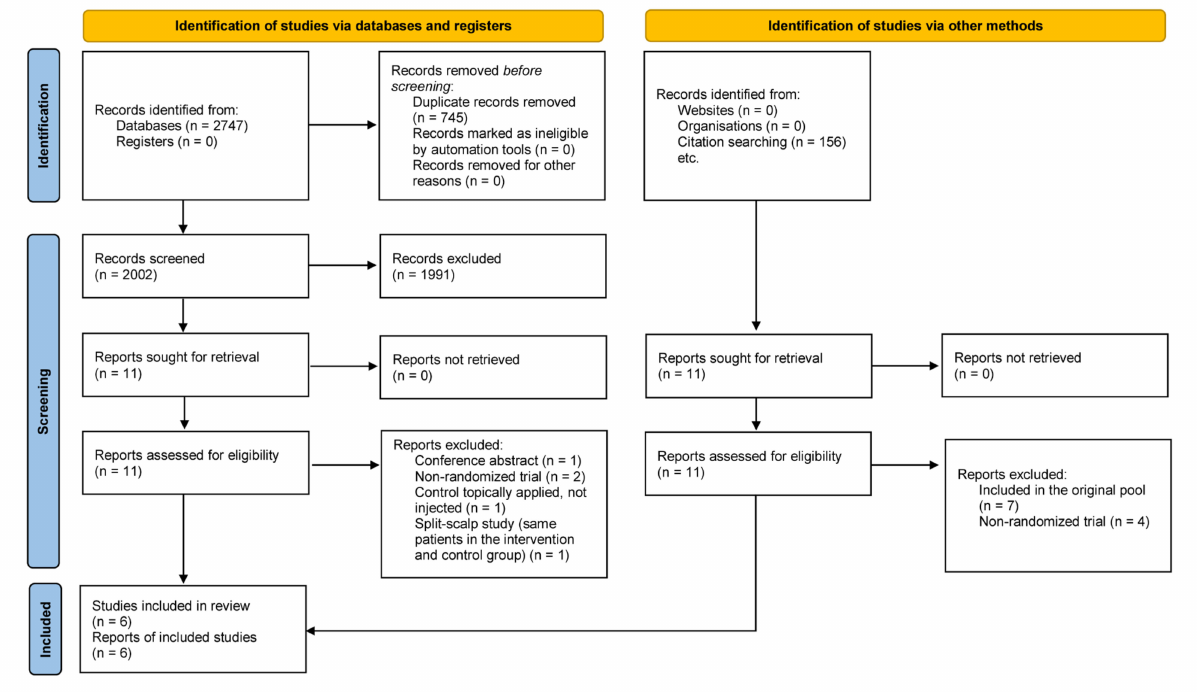
Figure 1. PRISMA flow diagram of the screening and selection process according to PRISMA 2020 guidelines [21].